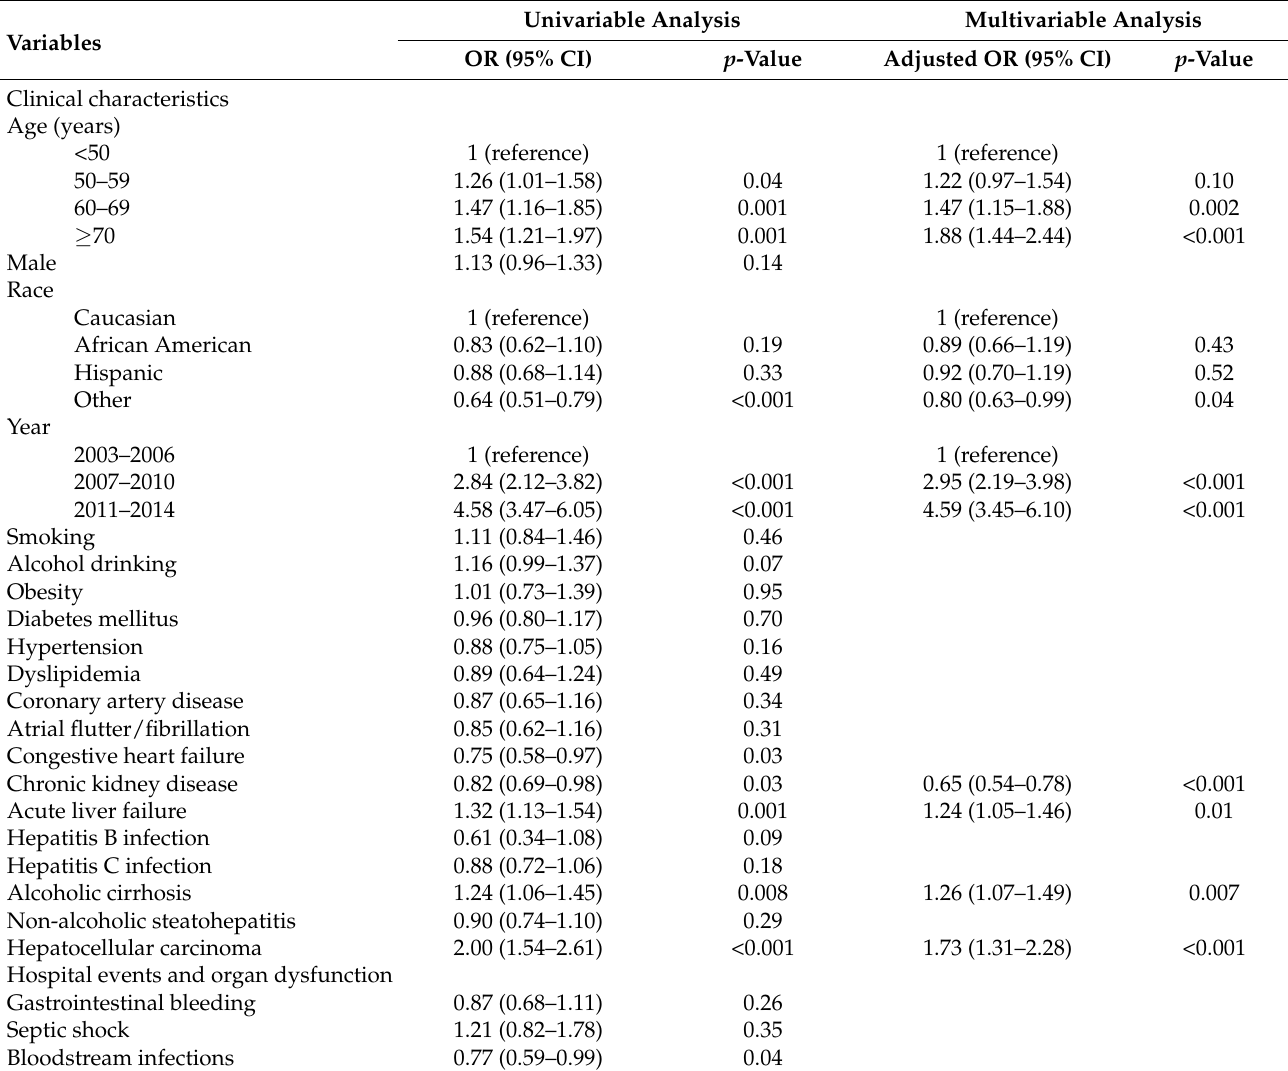
Table 2. Predictors of inpatient palliative service use in hospital admissions for hepatorenal